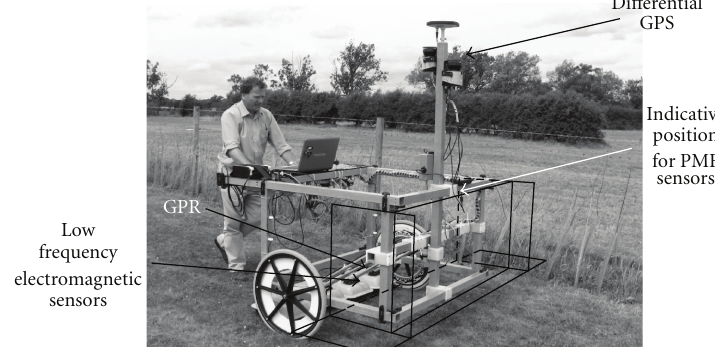
Figure 1: Example of one prototype multisensor cart with a commercial GPR, low frequency electromagnetic, and positioning sensors attached. The frame indicates the possible position for the PMF sensors.